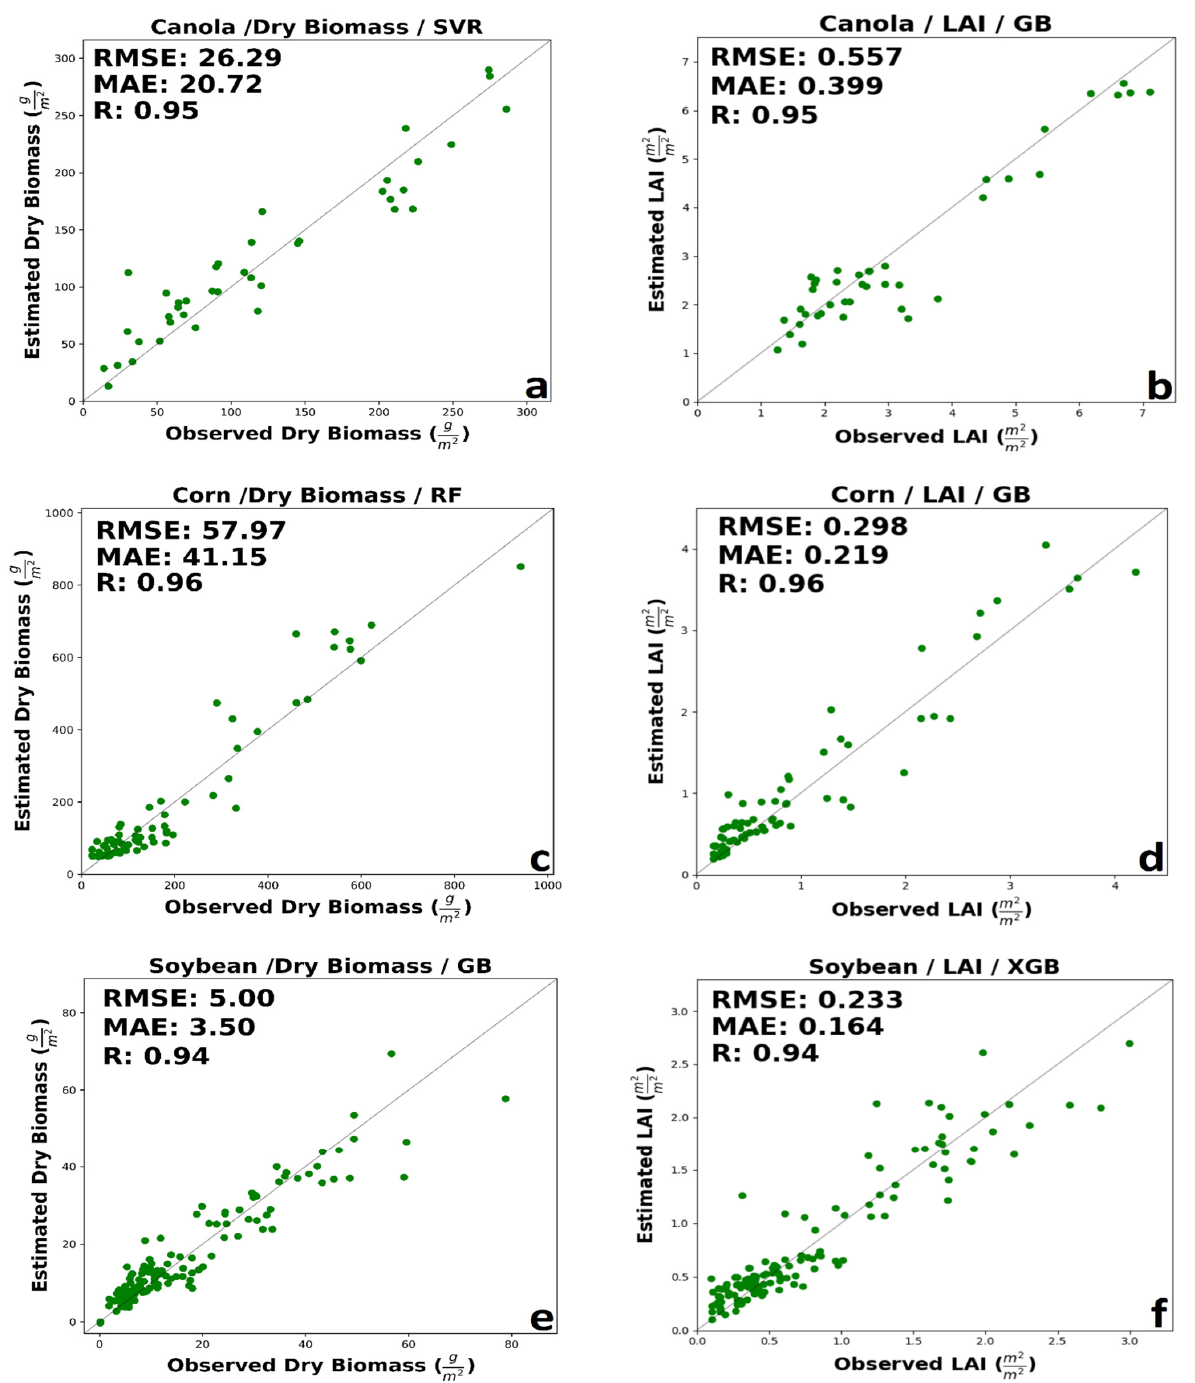
Figure 4. The best performance of machine learning regression models in estimating ( a ) canola dry biomass, ( b ) canola LAI, ( c ) corn dry biomass, ( d ) corn LAI, ( e ) soybean dry biomass, and ( f ) soybean LAI. For soybean’s dry biomass, generally, the integration of SAR and optical data had better performance. The estimation performance of SAR polarimetric data was slightly better than optic data in all cases. The best performance among MLAs was related to GB regression model with RMSE = 5.00 g/m 2 , MAE = 3.5 g/m 2 , and R = 0.94 (Figure 4e). SVR had the lower MAE among all algorithms; however, RF has the lower RMSE comparison to SVR. Also, RF and GB had a similar MAE, but RF had the lower RMSE. ML algorithms had a significant saturation in the high value of dry biomass (higher than 60 g/m 2